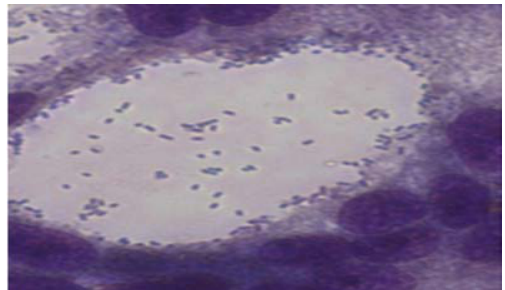
Fig. 6. (EnteroPLus) Lactobacillus rhamnosus GG adhesion study